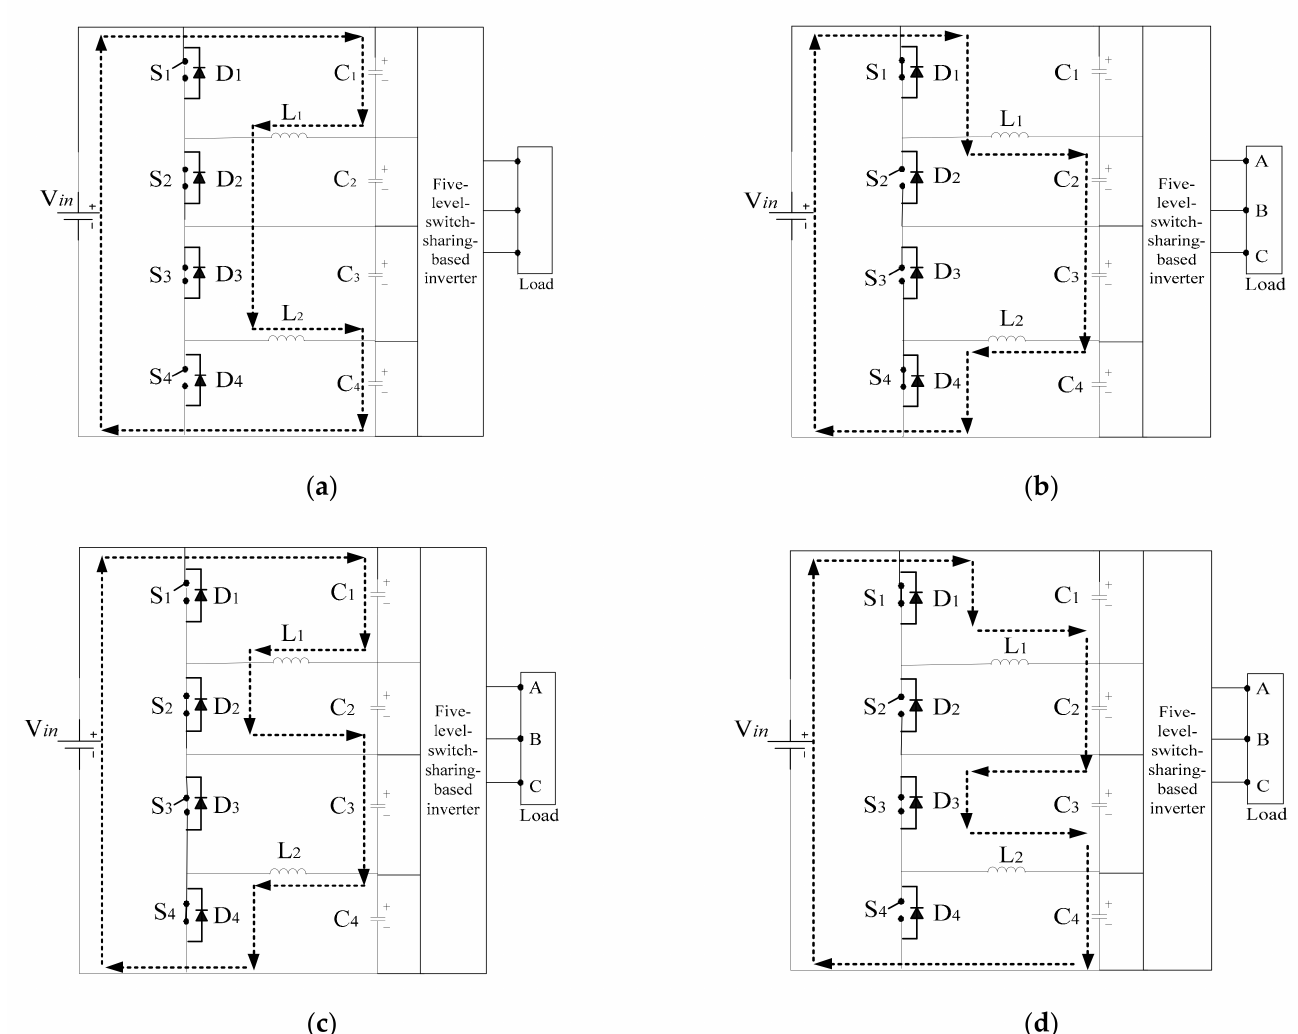
Figure 3. Different operating modes of the buck-boost converter. ( a ) Mode 1: (S 2 and S 3 ON, S 1 and S 4 OFF); ( b ) Mode 2: (S 1 and S 4 ON, S 2 and S 3 OFF); ( c ) Mode 3: (S 2 and S 4 ON, S 1 and S 3 OFF) and ( d ) Mode 4: (S 1 and S 3 ON, S 2 and S 4